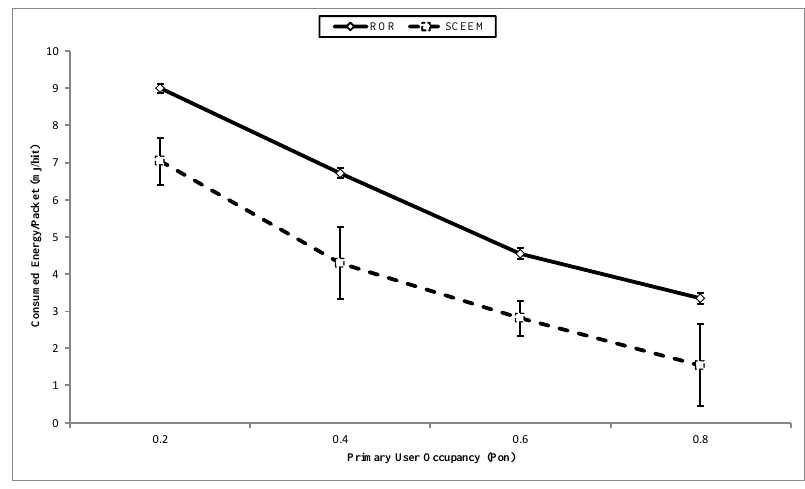
Figure 18. Consumed energy/packet vs . PU